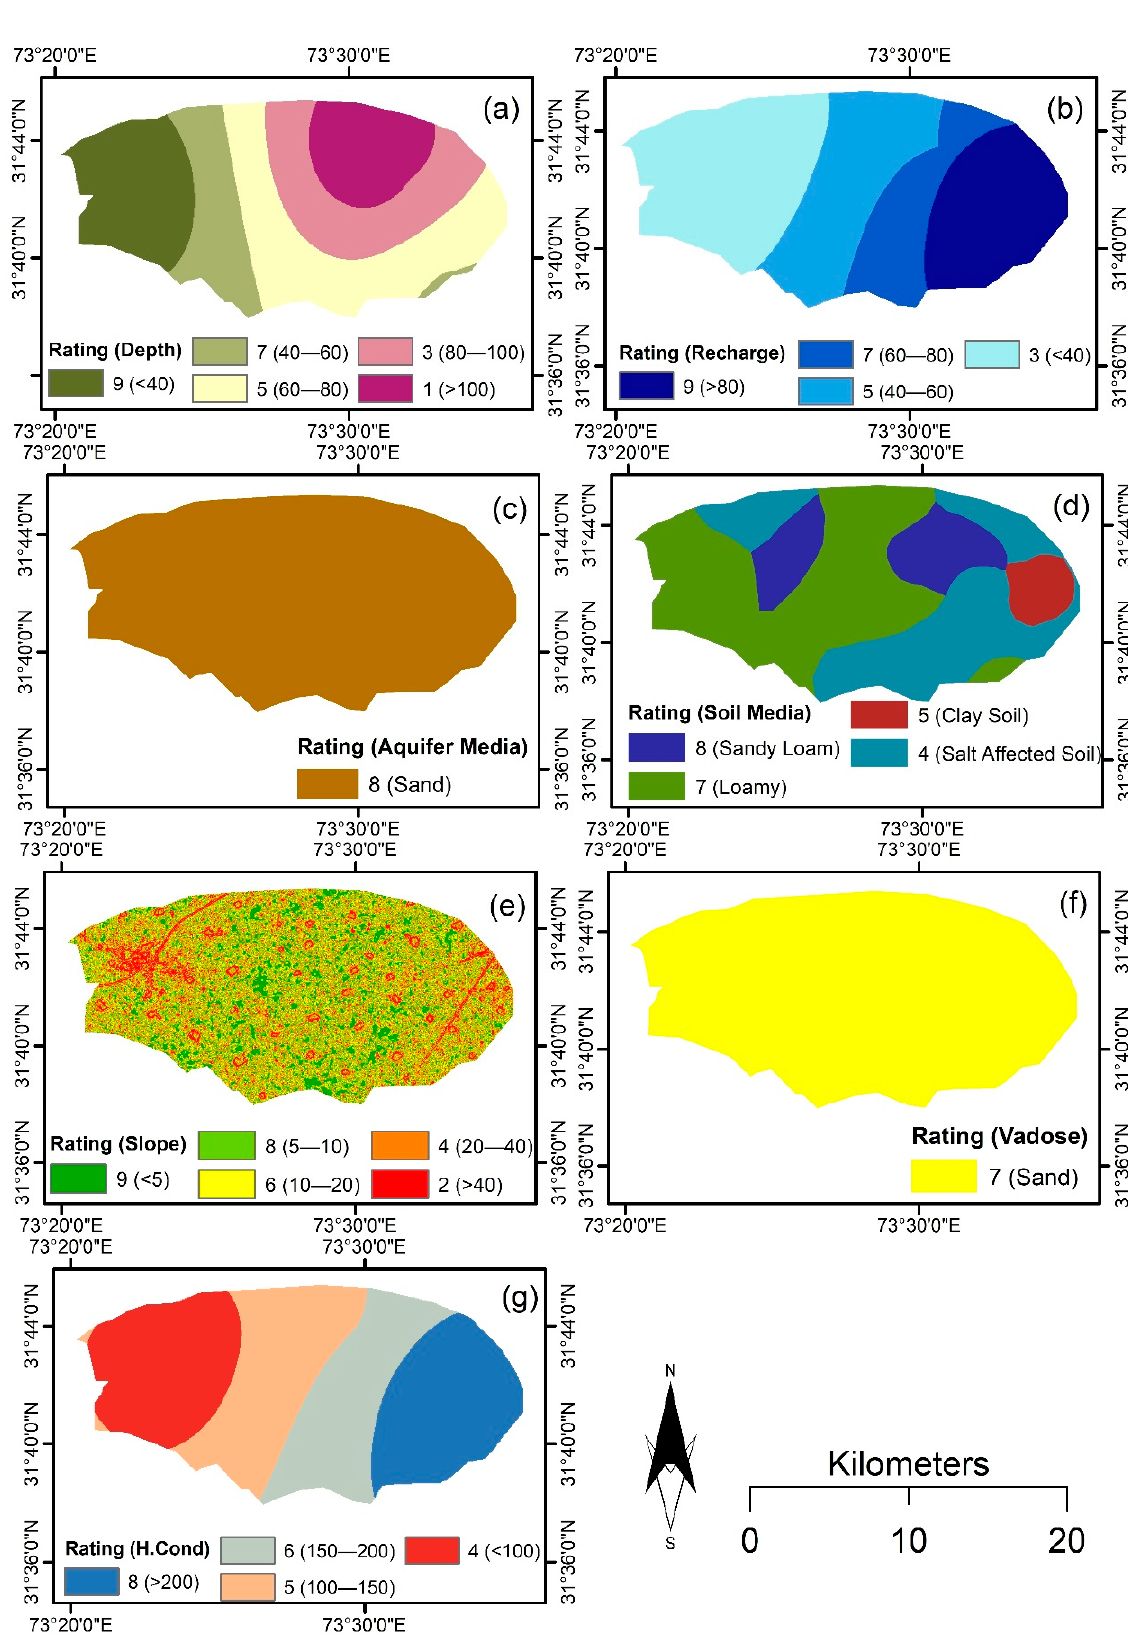
Figure 2. Seven thematic layers of the DRASTIC model: ( a ) depth to water table; ( b ) net recharge ( c ); aquifer media; ( d ) soil media; ( e ) slope; ( f ) vadose zone; and ( g ) hydraulic conductivity.